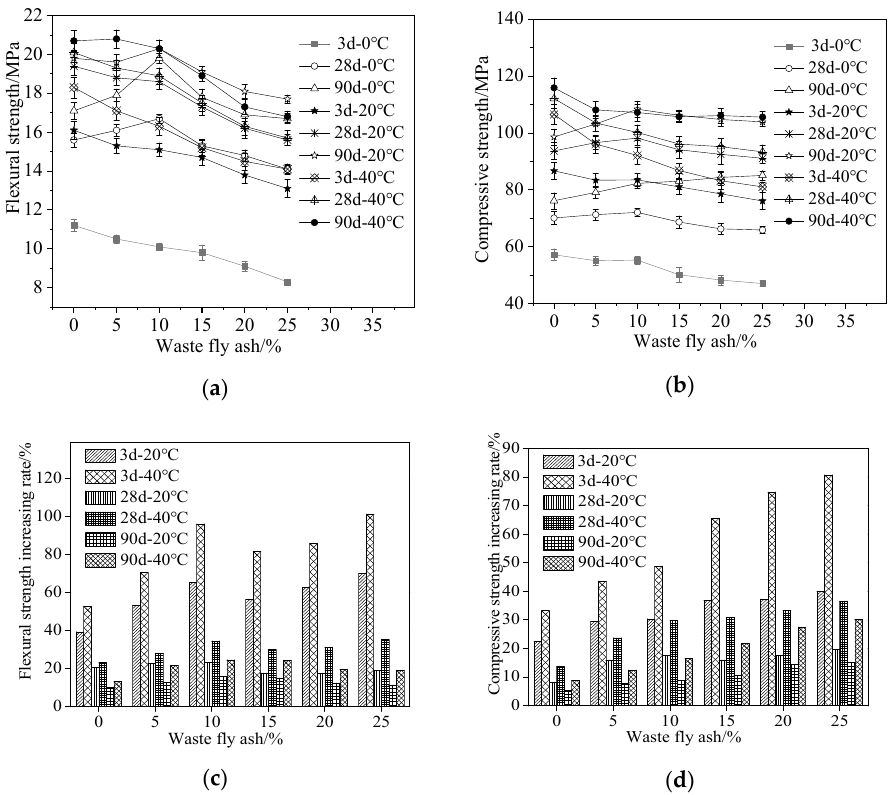
Figure 4. The mechanical strengths of RPC with WFA cured at different temperatures: ( a ) flexural strength; ( b ) compressive strength; ( c ) flexural strength loss rate; ( d ) compressive strength loss rate.